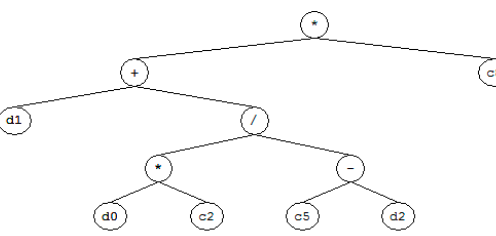
Figure 11. The fourth sub gene-expression tree.